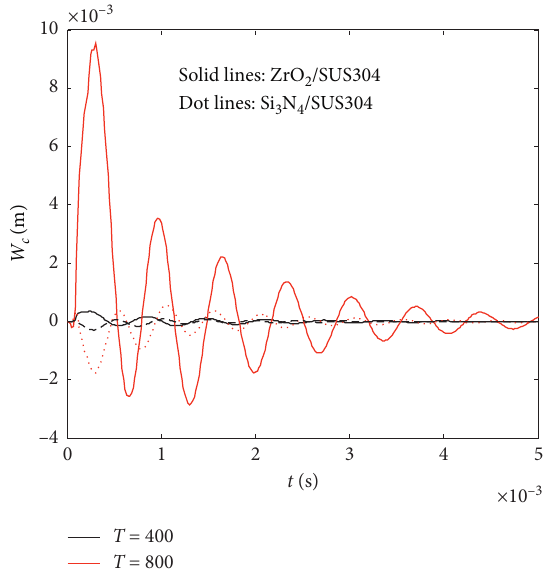
Table 10: Maximum deflection w